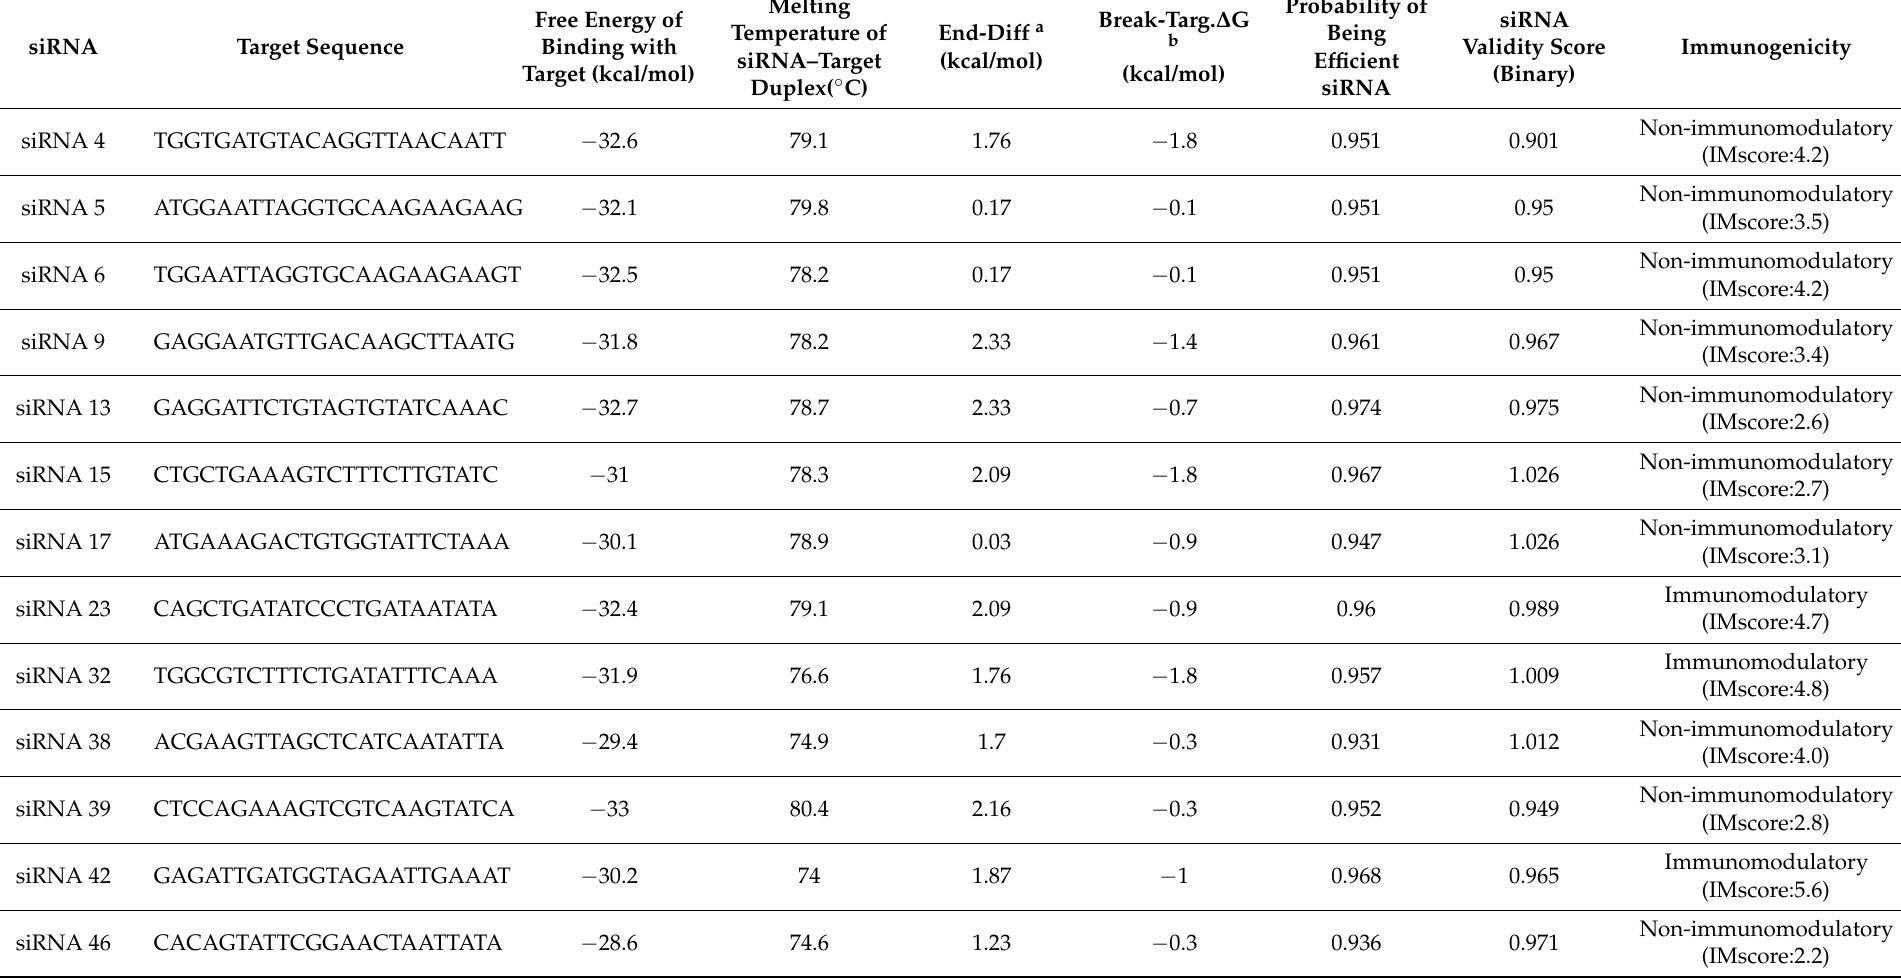
Table 3. Designed siRNA molecules with their respective free energy of binding with target, melting temperature of siRNA–target duplex, target accessibility, functional efficiency, and